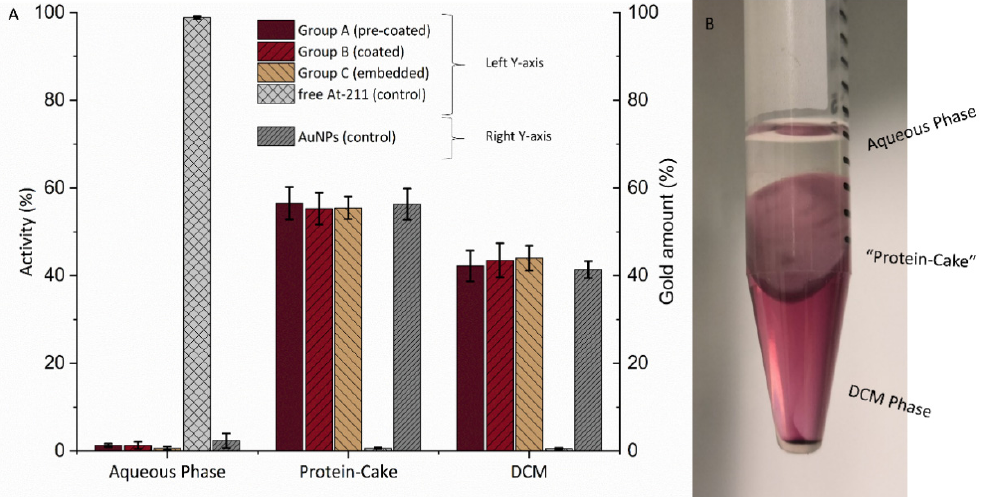
Figure 4. Serum stability of the 211 At-AuNPs in mouse serum. ( A ) Stability of the 211 At-AuNPs in mouse serum after 4 h at 37 °C (n = 3) compared to a control group of free 211 At (left axis). The gold content in each fraction was analyzed by ICP-OES (right axis) and was observed to correlate with activity for the AuNP samples, indicating high stability of the 211 At-radiolabel in all groups. ( B ) This image shows the distribution of PEG-coated 211 At-AuNPs observed as red coloration between the aqueous phase (top), the “protein cake” (middle) and the DCM phase (bottom), after centrifugation.